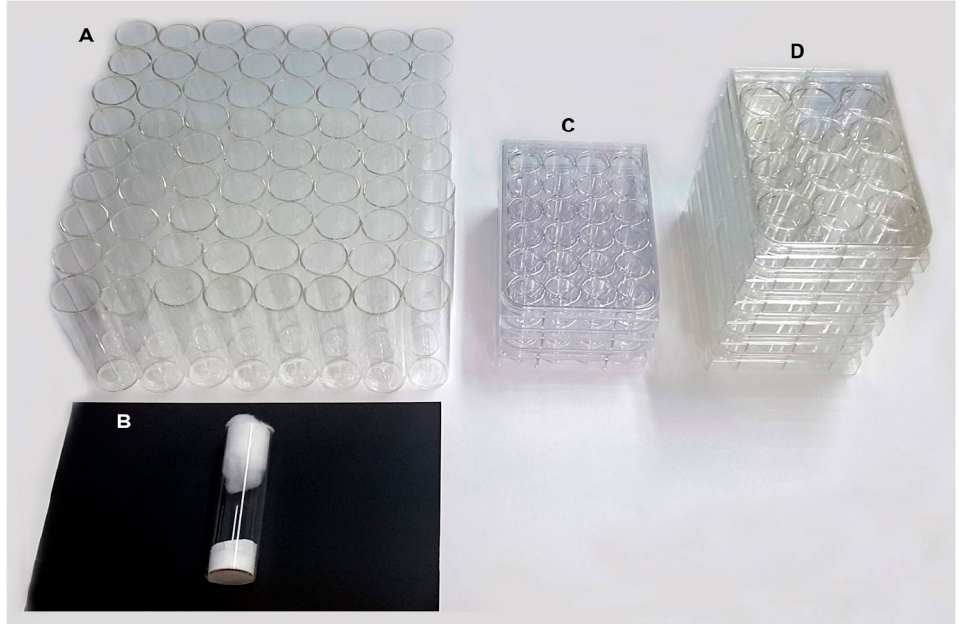
Figure 4. Comparison of the area used to perform oviposition experiments with Drosophila vials device when 72 gravid Ae. aegypti females are required and the proposed oviplates necessary to fit the same number of females. ( A ) The 72 Drosophila vials occupying 4100 cm 3 of insectary space. ( B ) The Drosophila vial set up as an individual oviposition device. ( C ) Three 24-well plate occupying 700 cm 3 . ( D ) Six 12 well plate occupy 1400 cm 3 .